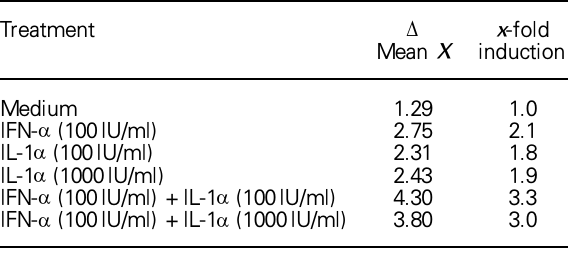
Table 1. Induction of PML protein by IFN- a , IL-1 a or a combination of both in human diploid fibroblasts Treatment